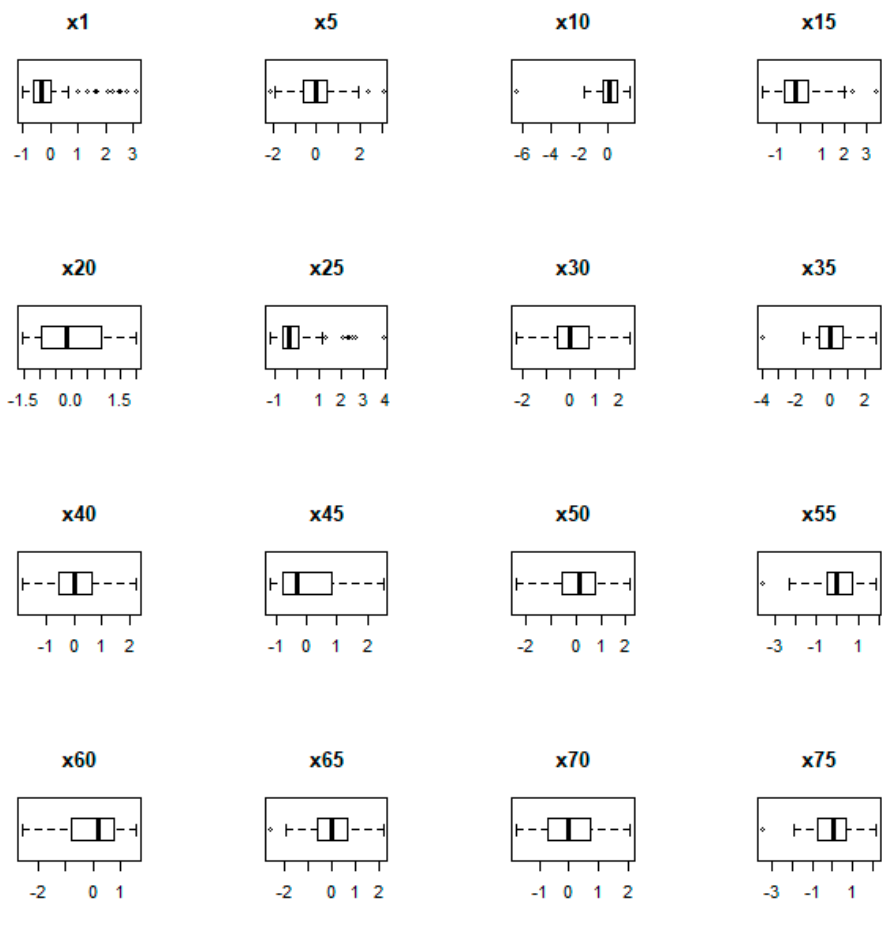
Figure 3. The boxplot of sample leukemia genes.